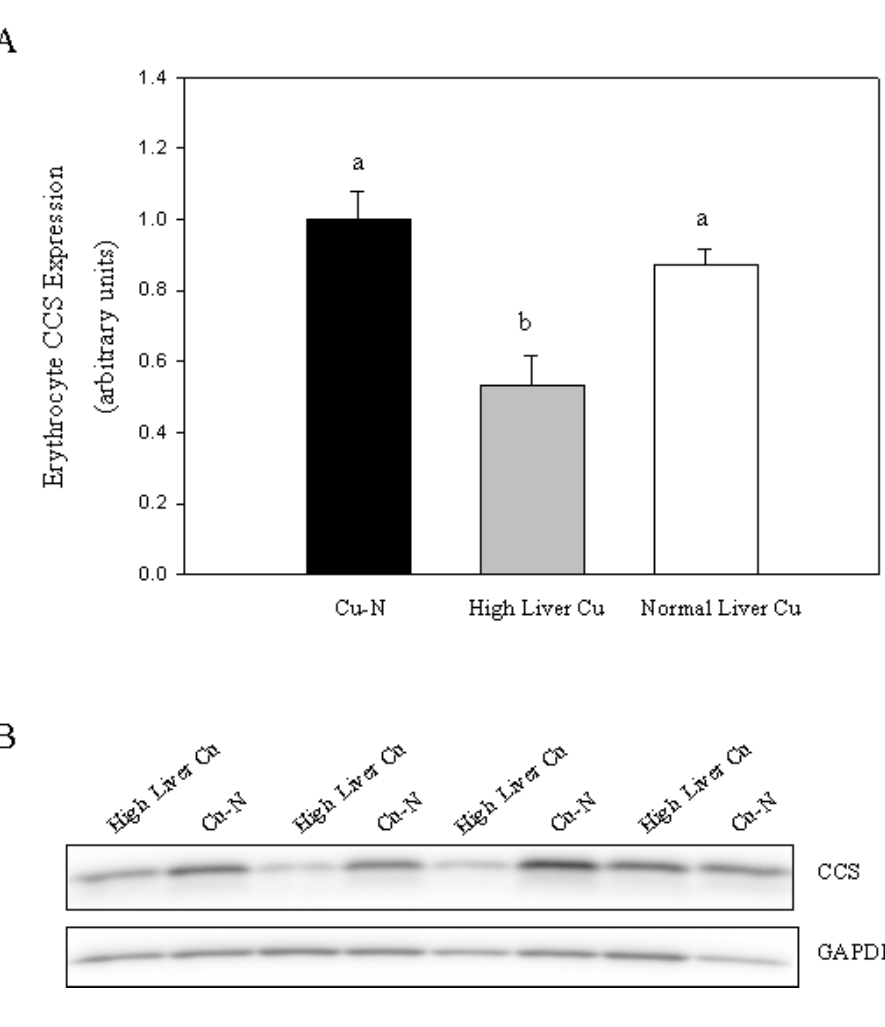
Figure 3. Relative CCS expression in erythrocytes of rats fed diets with normal amounts of Cu (Cu-N) or high levels of Cu displaying high (High Liver Cu) or normal (Normal Liver Cu) liver Cu concentrations. CCS expression in erythrocytes was quantified and expressed relative to GAPDH expression ( A ). The mean for Cu-N rats was arbitrarily set to 1. Values are means  SEM, n = 7, 4 and 10 for Cu-N, High Liver Cu and Normal Liver Cu, respectively. Bars without a common letter differ, P  0.05. Representative Western blot showing erythrocyte CCS expression in rats fed normal Cu (Cu-N) or rats fed high Cu and having high liver Cu concentrations (High Liver Cu) ( B ). CCS expression was detected with a CCS-specific antibody (top panel). The membrane was stripped and probed with an antibody against GAPDH (bottom